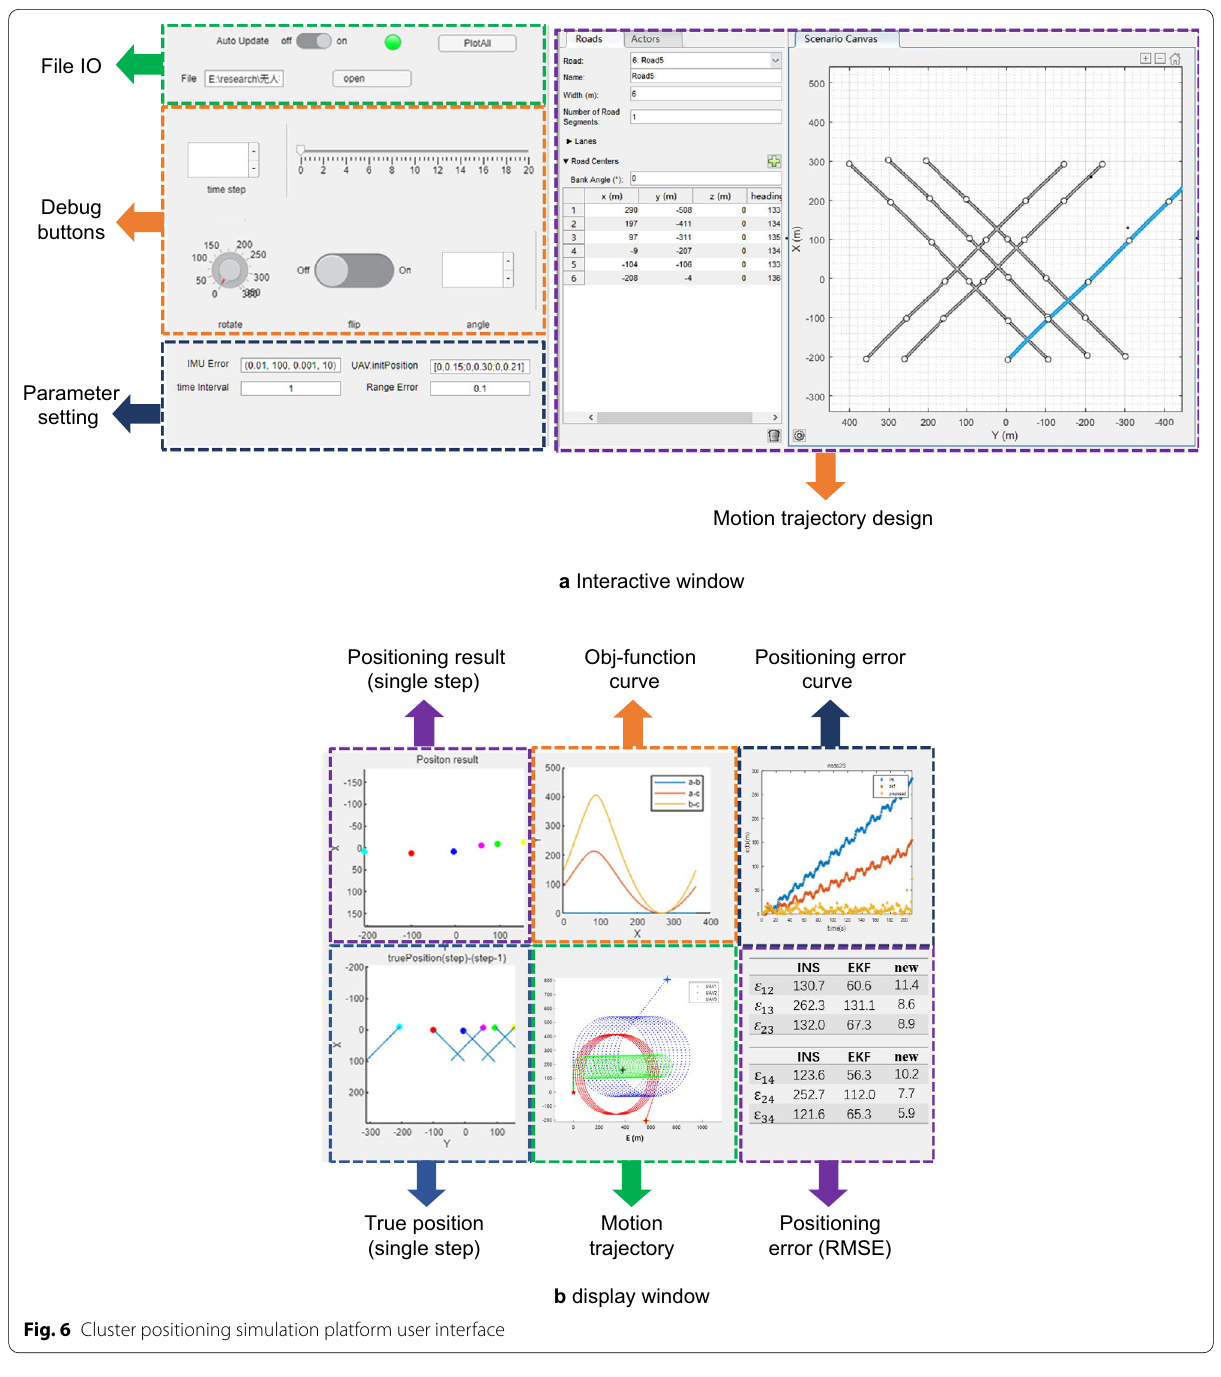
Fig. 6 Cluster positioning simulation platform user